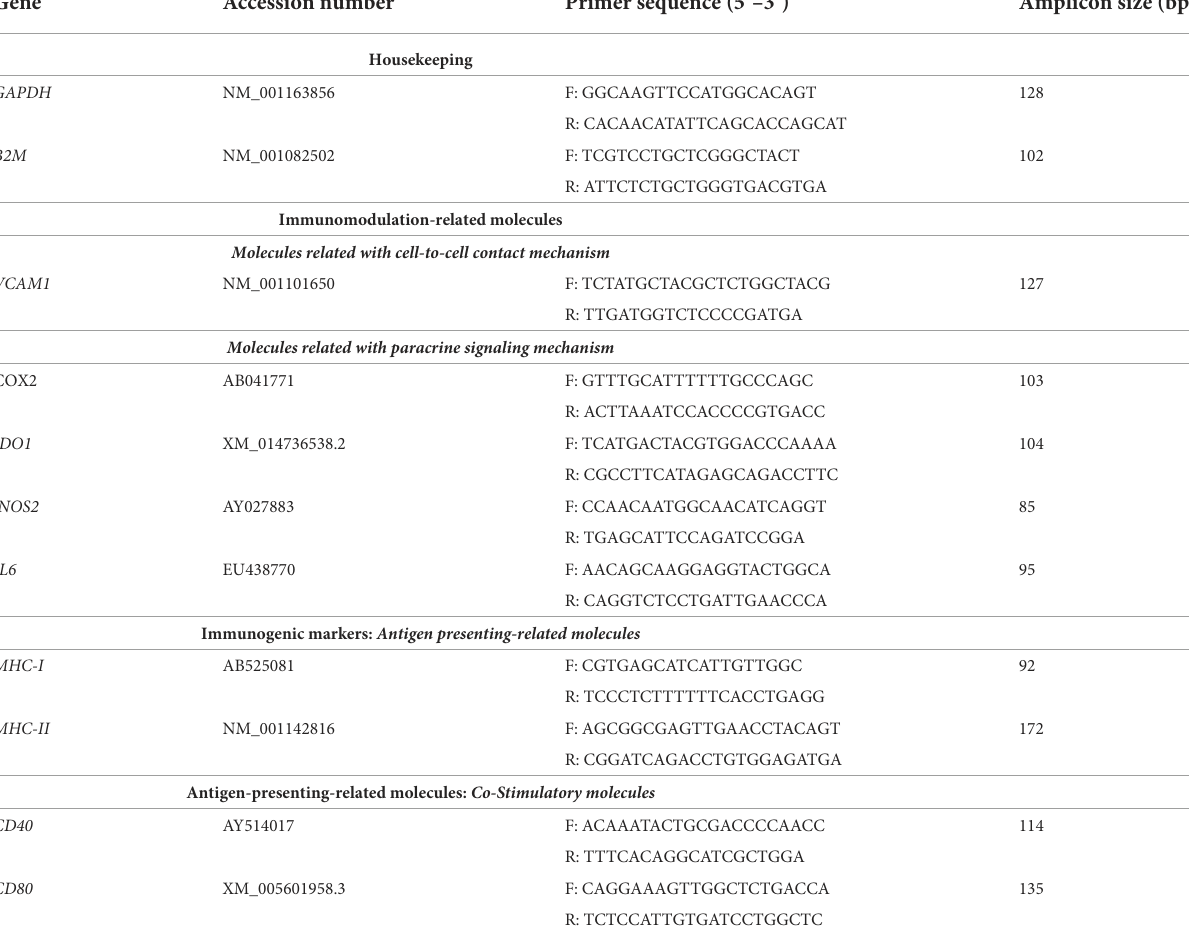
TABLE 1 Primers used for gene expression analysis by RT-qPCR.